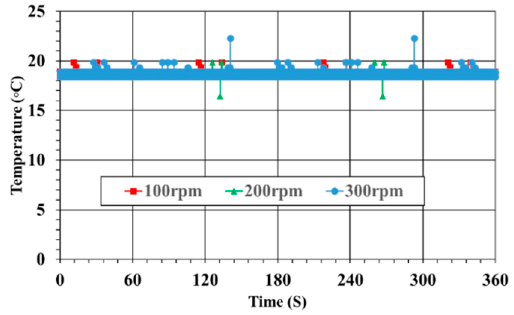
Figure 8. Bearing